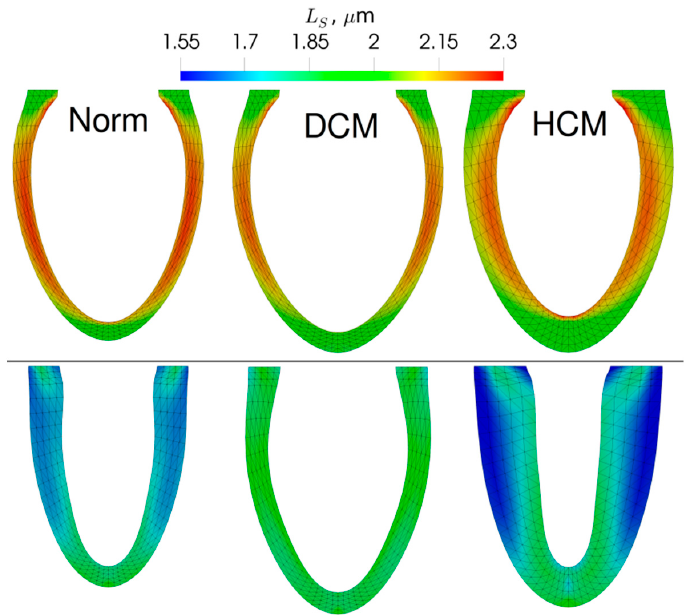
Figure 4. The end-diastolic (top) and end-systolic (bottom) LV geometry for the models of the normal (Norm), dilated (DCM), and hypertrophic (HCM) LV obtained during the simulations. The color code shows sarcomere length.